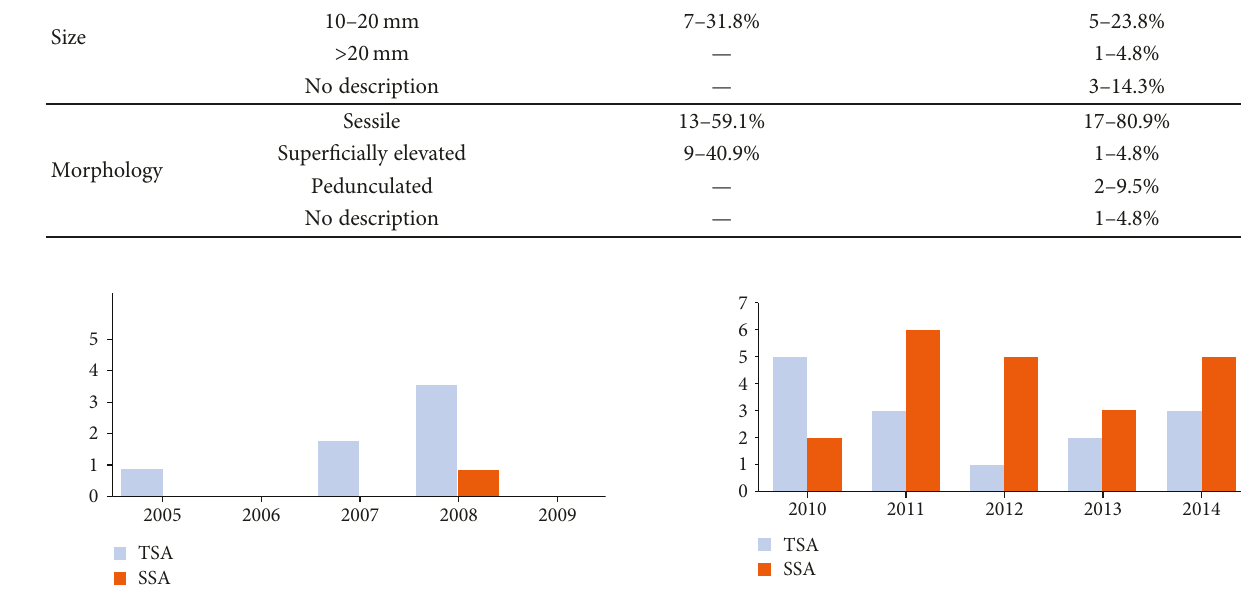
Figure 1: Number of sessile serrated adenomas and traditional serrated adenomas from 2005 to (year; lesions diagnosed — absolute value). One case of traditional serrated adenoma was diagnosed in 2005, two in 2007, and four in 2008. One case of sessile serrated adenoma was diagnosed in 2008.